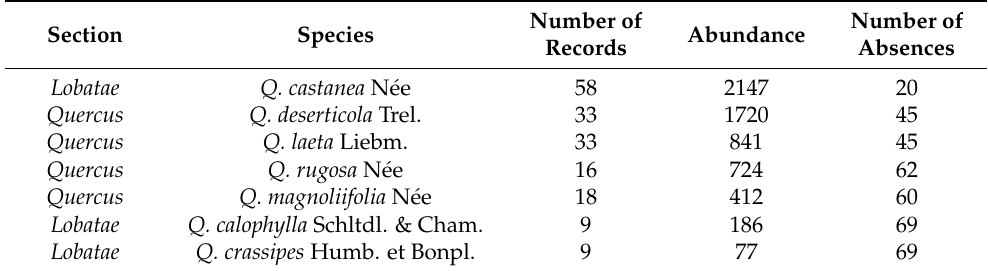
Table 1. Number of occurrence records, abundance and number of absences of the seven most abun- dant Quercus species registered in the 78 vegetation censuses in the Cuitzeo Lake basin, Michoac á n state, Mexico